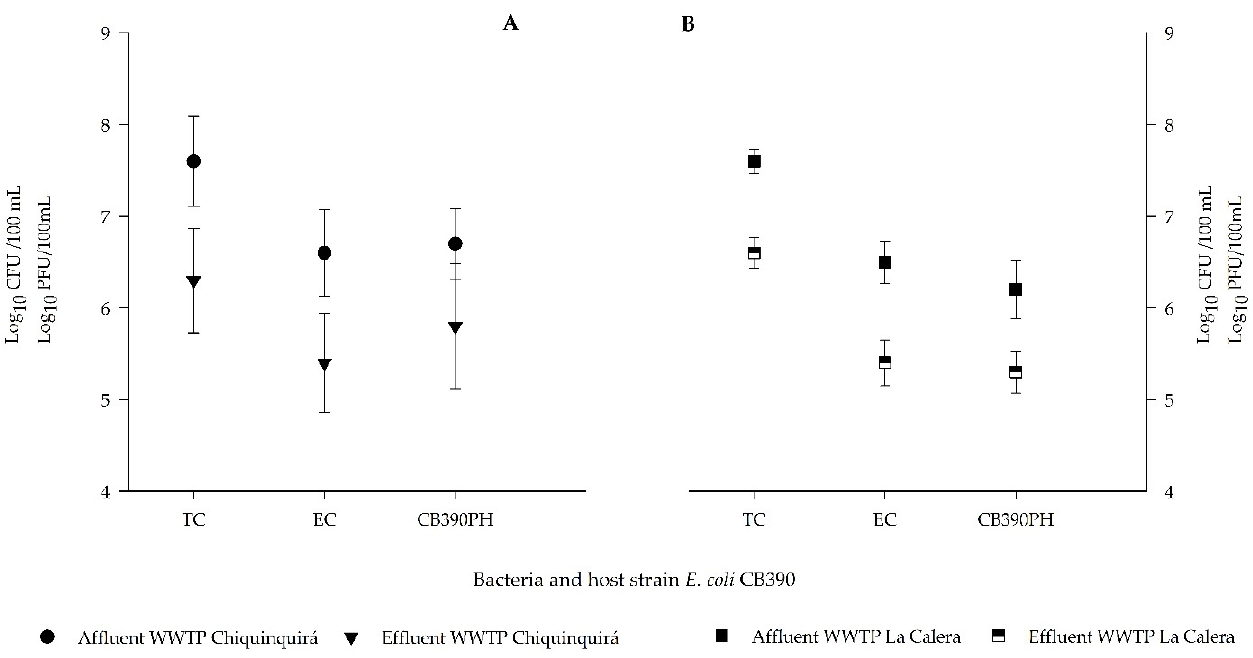
Figure 6. Affluent and effluent total C, E. coli and C390 phage concentration in samples collected from Chiquinquirá ( A ) and La Calera ( B ) WWTPs. TC: Total Coliforms, EC: E. coli , PHCB390: CB390 phages.